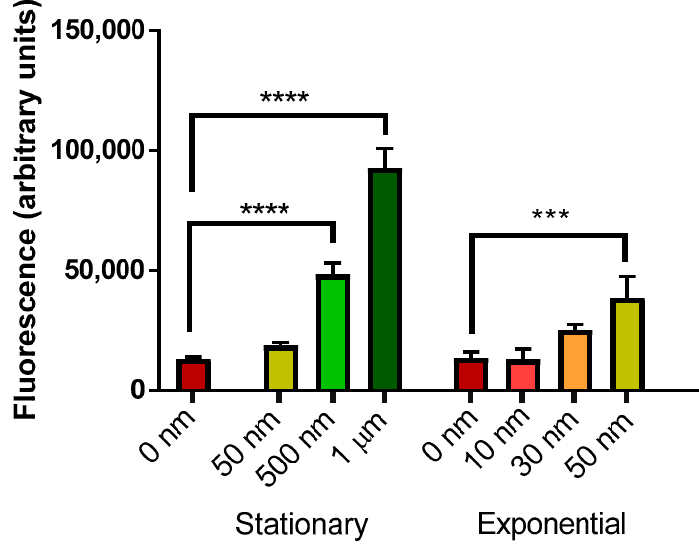
Figure 4. Measurement of mCherry fluorescence of BY4743 [pYHSRed1] cells in stationary and exponential phase growth treated with oligomeric A β 42 . Data are shown as mean ± SEM of triplicate measurements; *** p > 0.001, **** p < 0.0001.